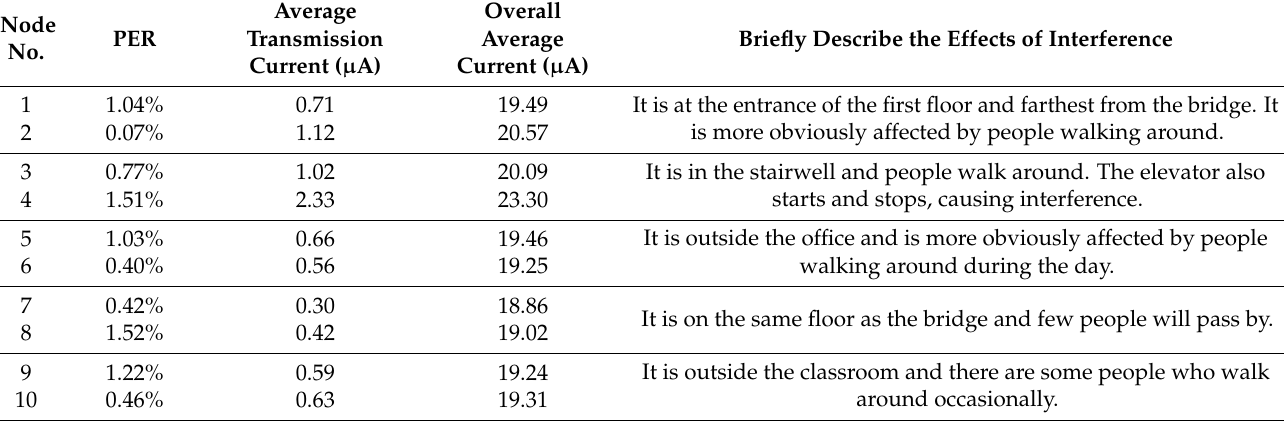
Table 8. Statistics of each sensor